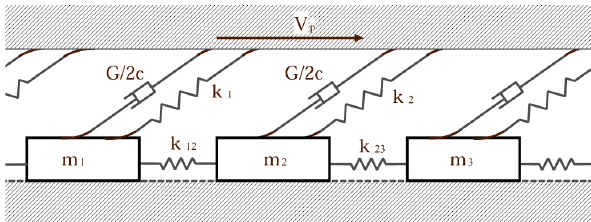
Fig. 1. Diagram of the spring-slider-dashpot system. The config- uration is identical to the Burridge–Knopoff model (Burridge and Knopoff, 1967), except that it is also equipped with dashpots and the friction on the bottom of the sliders is rate- and